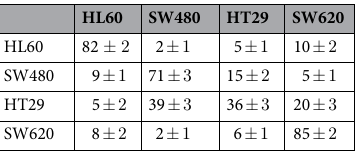
Table 2. k-fold validation tests to classify the four cell lines (5-fold). Shows that 100% of the HL60 can be classified correctly as HL60, and that 85% of SW480 were classified correctly. HT29 and SW620 were harder to classify, the average classification of the four cell lines was 69 ± 1%. The rows represent the actual cell type and the columns represent the predicted cell